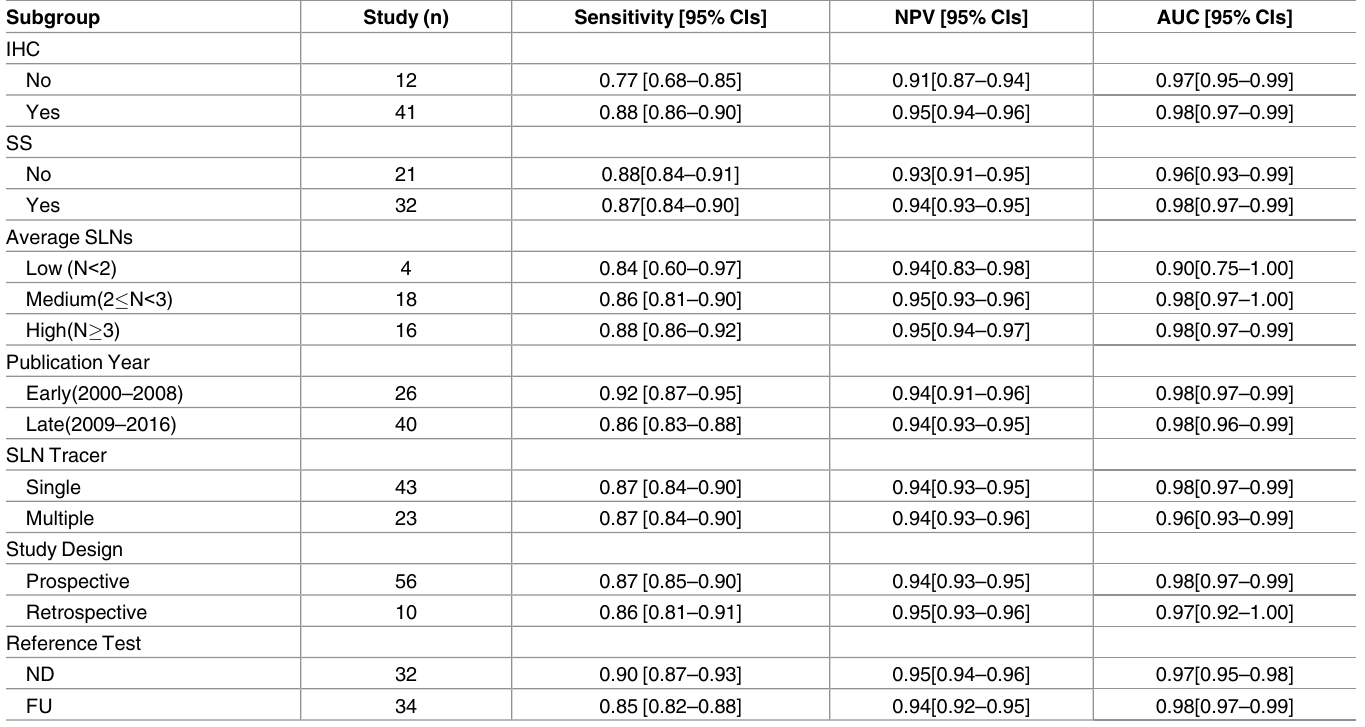
Table 2. Summaryof subgroup analysis by different clinical characteristics.